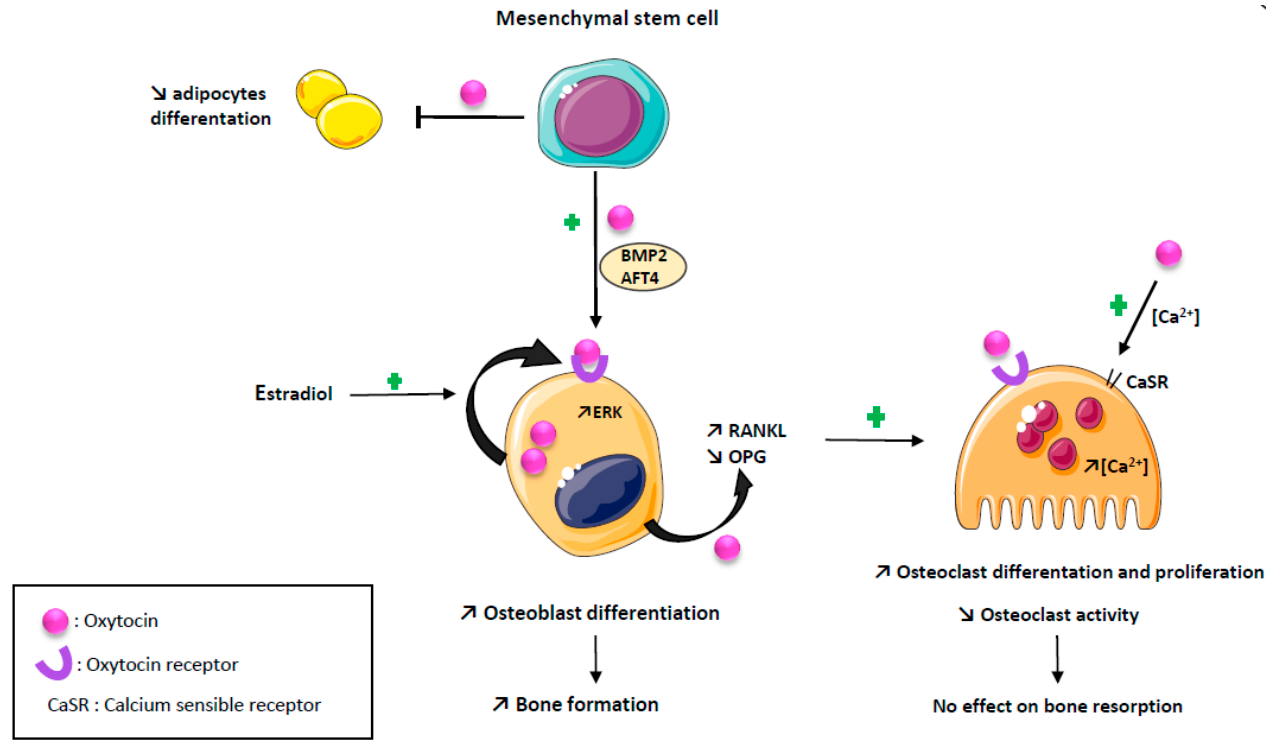
Figure 1. Effects of oxytocin on bone cells. Oxytocin has an anabolic action promoting osteoblast differentiation and function by an upregulation of BMP2 and AFT4 pathways, and reducing adipogenesis. Estradiol positively stimulate oxytocin production by osteoblast through an activation of the MAP kinase/ERK pathway and oxytocin receptor expression, synergistic with a local feed-forward loop. Oxytocin has a paradoxical effect on osteoclast resulting in no effect on bone resorption: osteoclast number is increased by promoting RANKL expression and decreasing OPG expression; mature osteoclast resorption is decreased by supporting intracellular calcium concentration.